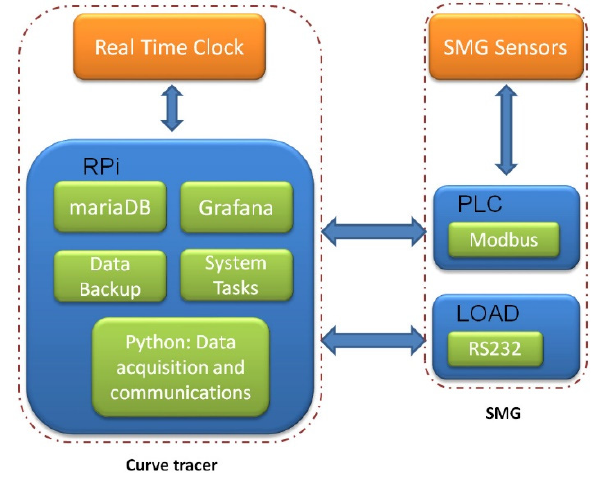
Figure 3. Functionalities implemented by the curve tracer.